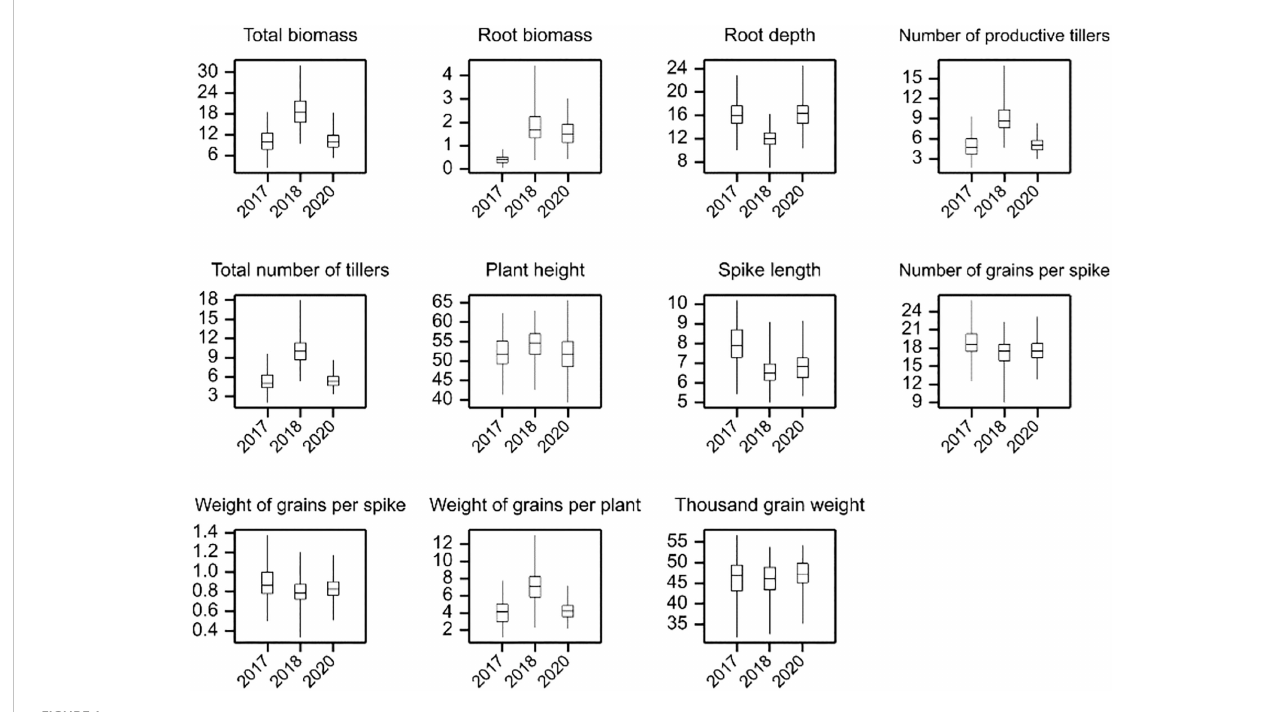
FIGURE 1 Distributions of genotypic means in